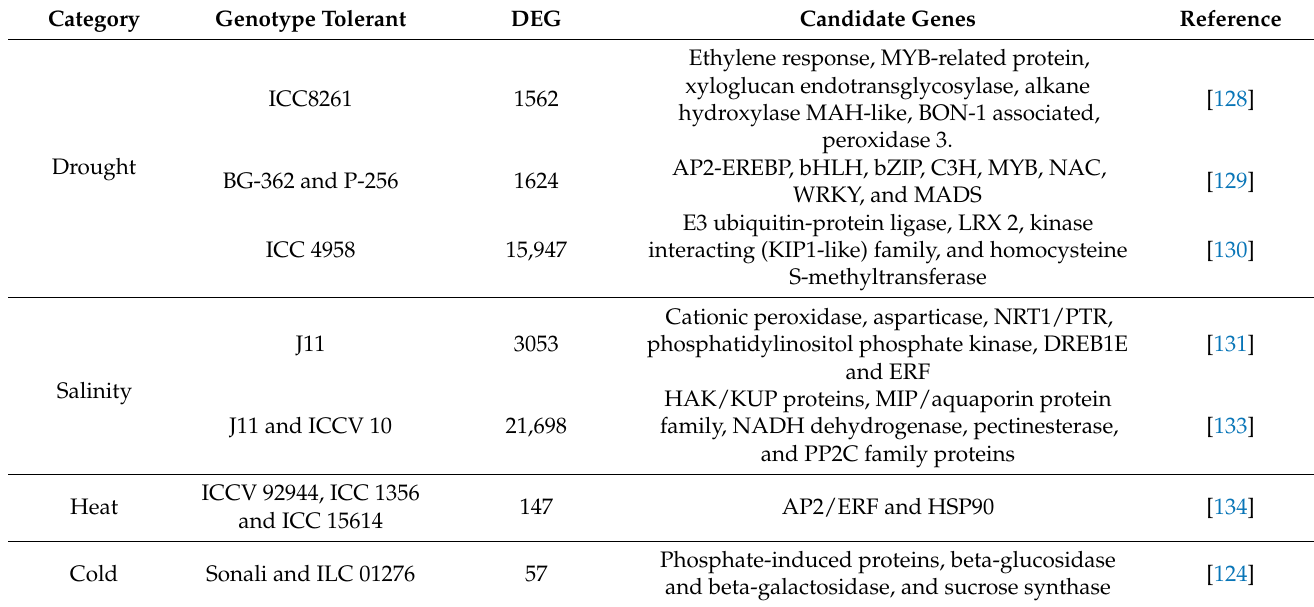
Table 4. Some functional genomics studies carried out in chickpea for traits related to abiotic